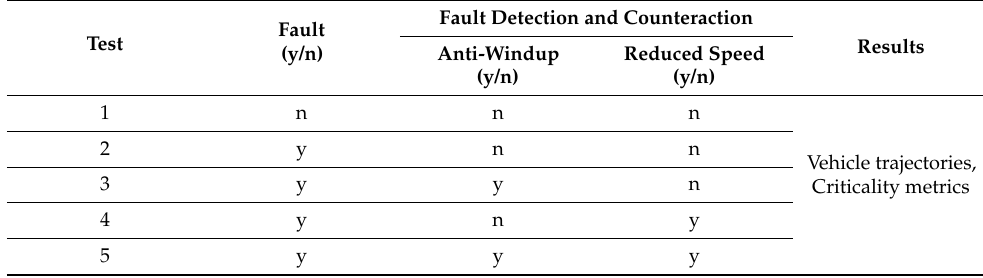
Table 1. List of conducted simulations of the ego vehicle.